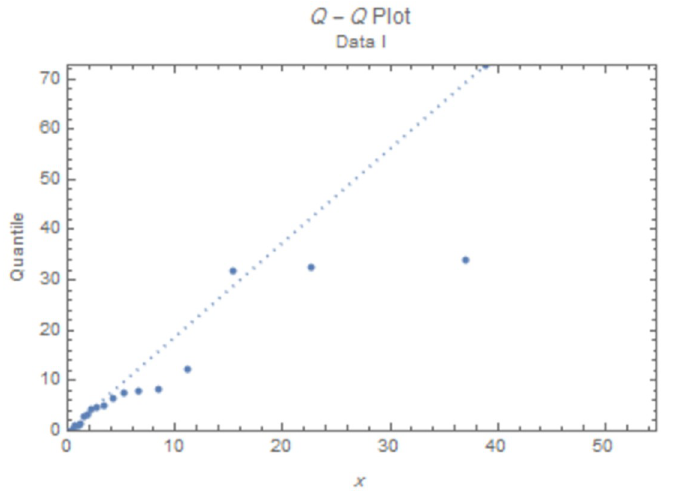
Fig 8. Q-Q plot for data I.